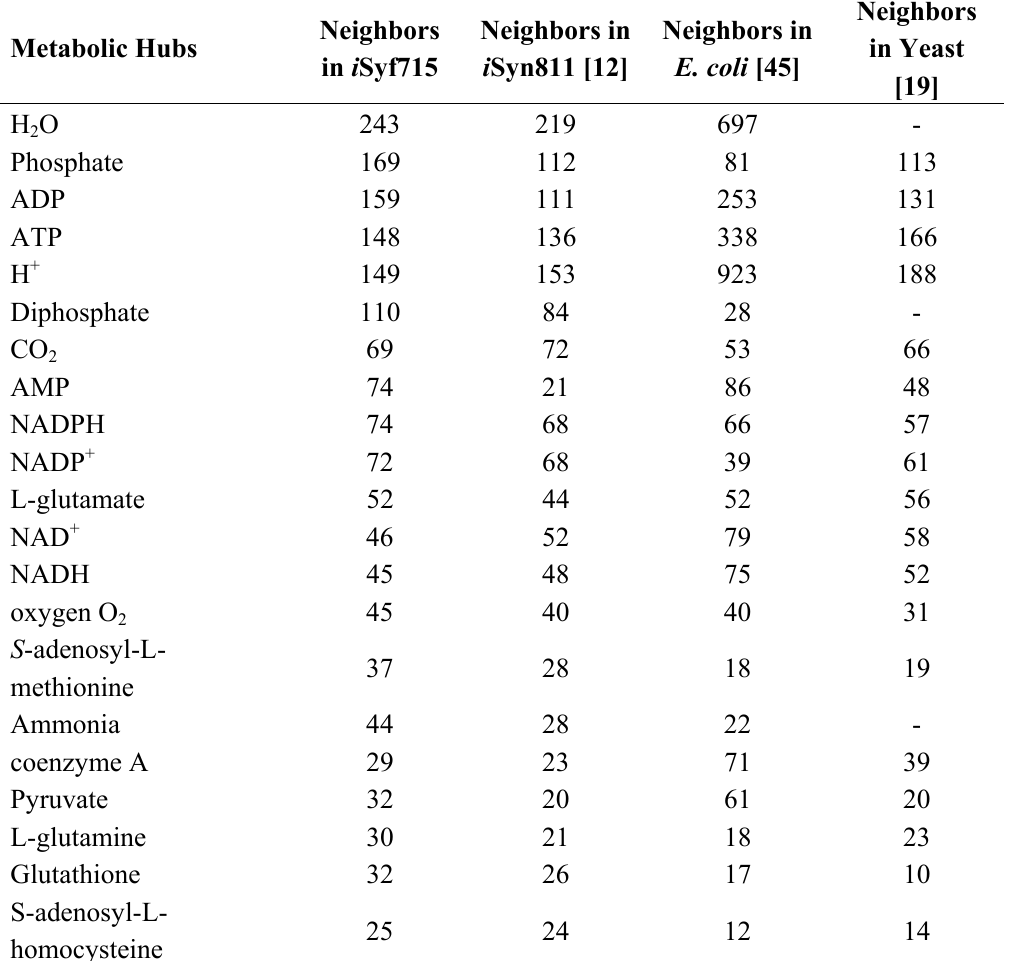
Table 3. Most connected metabolites in S. elongatus PCC7942 and other genome-scale metabolic